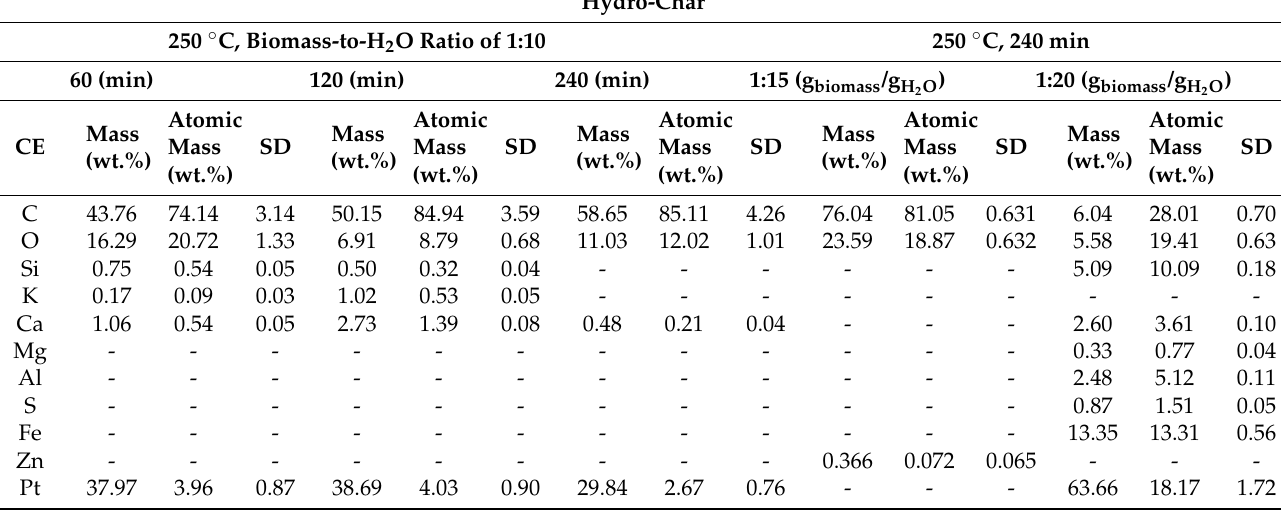
Table 2. Percentages in mass and atomic mass of hydro-char obtained by the hydrothermal carboniza- tion of corn stover at 250 ◦ C after 60, 120 and 240 min with a biomass-to-H 2 O ratio of 1:10 and at 250 ◦ C after 240 min with biomass-to-H 2 O ratios of 1:10, 1:15 and 1:20 using a pilot-scale reactor of a reactor of 18.75